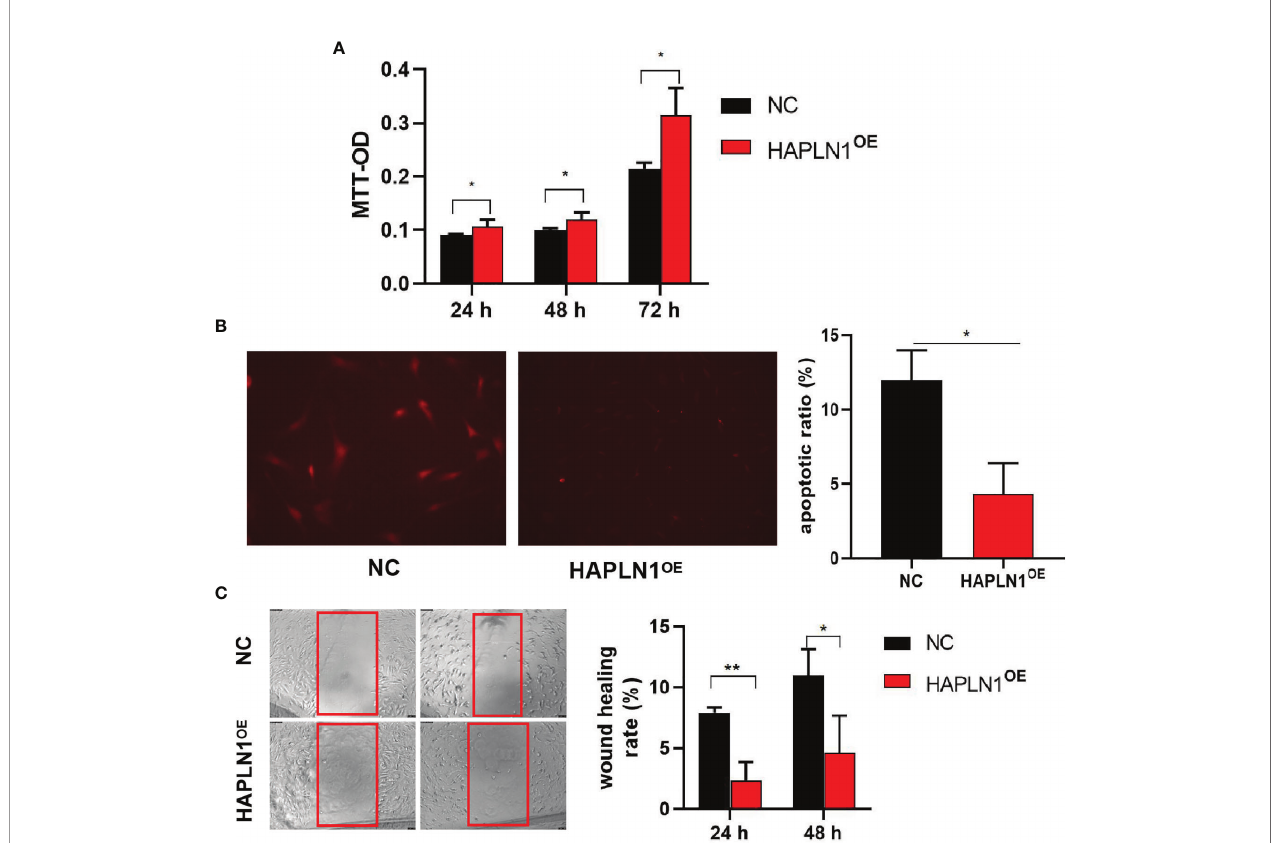
FIGURE 3 | Effects of HAPLN1 over-expression on RA-FLSs activity. Over-expression of HAPLN1 (HAPLN1 OE ) in RA-FLSs signi fi cantly increased the (A) proliferation but reduced (B) apoptosis (magni fi cation: 10×10) and (C) migration (magni fi cation: 10×5) of RA-FLSs. *p < 0.05; * *p < 0.01. NC, negative control is control plasmid vector of HAPLN1 OE